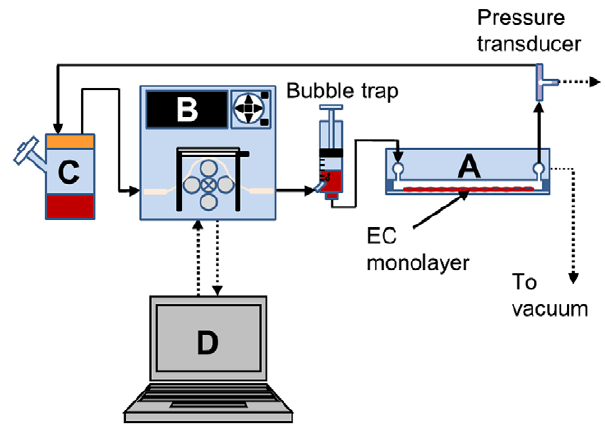
Figure 1. Parallel plate culture system. Endothelial cell monolayers were grown to confluence on glass coverslips, then affixed to parallel plate flow chambers (A) using a vacuum pump. Peristaltic pumps (B) are used to impose pulsatile flow of culture media (C) over the endothelial monolayers. The rotational speed of the pumps is controlled by an external computer (D) via RS-232